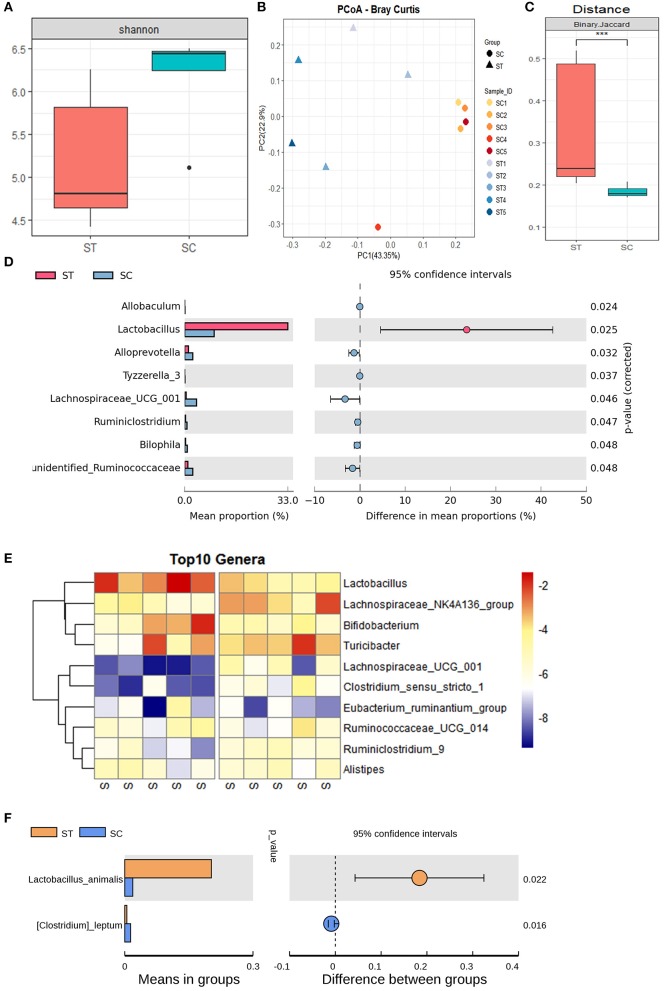
WBV altered the composition of the mouse intestinal microbiota. (A) The α-diversity of mouse intestinal microbiota; the PCoA (B) and distance of β-diversity (C) analysis of the mice in the vibration and control groups; (D) the bacteria with significant differences between the two groups; (E) the Heat map of the bacteria with significant differences; (F) the content of Lactobacillus animalis in the vibration and control groups. ***p < 0.001.